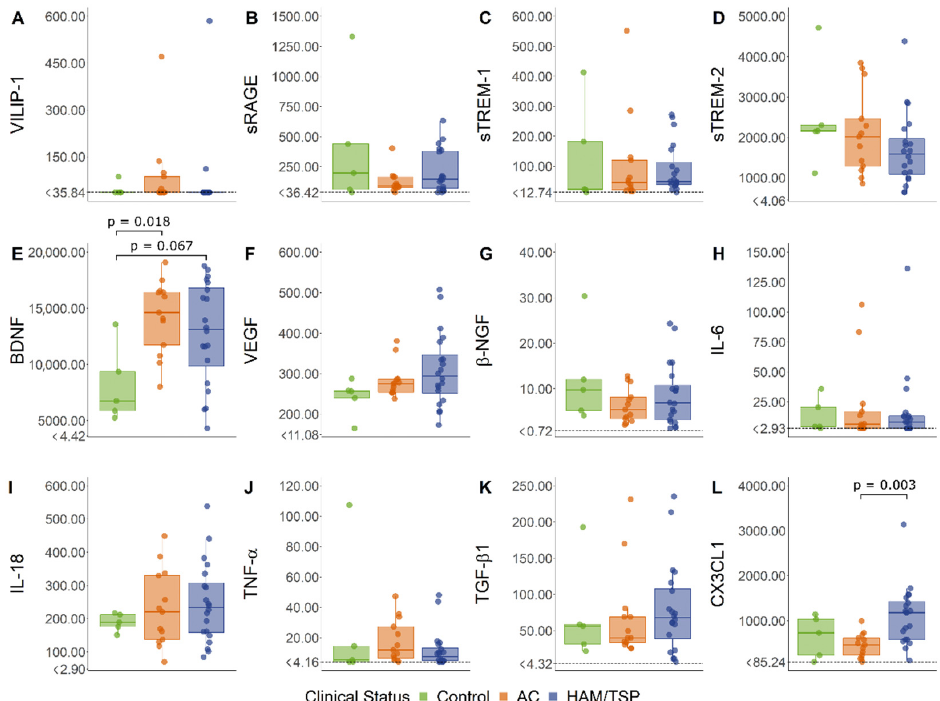
Figure 1. Serum levels of common biomarkers of neuroinflammation. ( A ) VILIP-1, ( B ) sRAGE, ( C ) sTREM-1, ( D ) sTREM-2, ( E ) BDNF, ( F ) VEGF, ( G ) β -NGF, ( H ) IL-6, ( I ) IL-18, ( J ) TNF- α , ( K ) TGF- β 1, and ( L ) CX3CL1 (fractalkine) levels were simultaneously determined with a multiplex bead-based immunoassay by flow cytometry in serum samples from asymptomatic HTLV-1 carriers (AC) ( n = 13), HAM/TSP patients ( n = 20), and a control group of HTLV-1-seronegative individuals ( n = 5). A normal distribution was determined by the Kolmogorov–Smirnov test. The statistical analysis of parametric variables was performed with